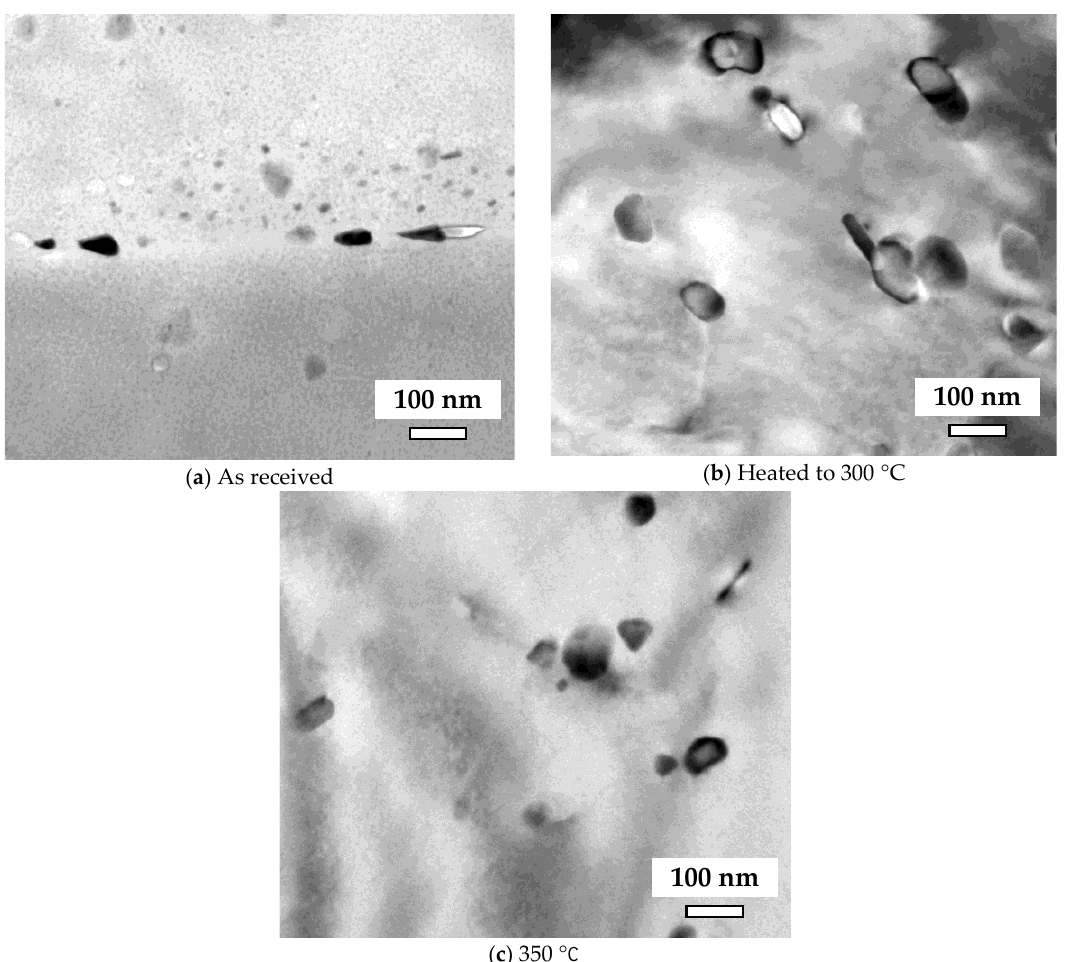
Figure 3. Typical TEM observations on the quenched samples that were heated to different temperatures using a heating rate of 1 °C/s. ( a ) As-received, ( b ) heated to 300 °C and ( c ) heated to 350 °C.